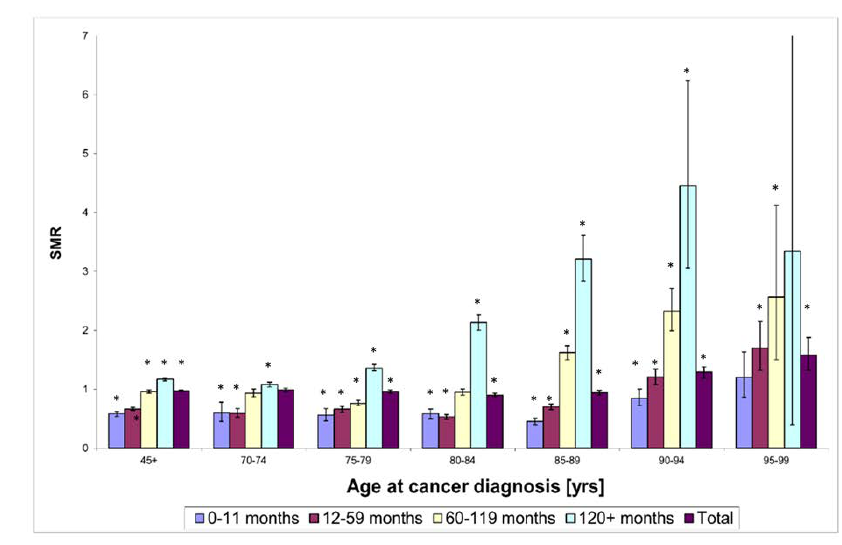
Figure 1. Standardized mortality ratios (SMRs) for death due to AD in white-race patients diagnosed with cancer at 45 + years of age. SMRs are stratified by 5-year age groups at cancer diagnosis and five follow-up intervals after cancer diagnosis. Error bars correspond to 95% confidence intervals (CI) for SMR (the upper-bound 95% CI for age group 95–99 years and latency 120 + months has a value of 12.05, which exceeds the maximum on the vertical scale); * p < 0.05 (not adjusted for multiple